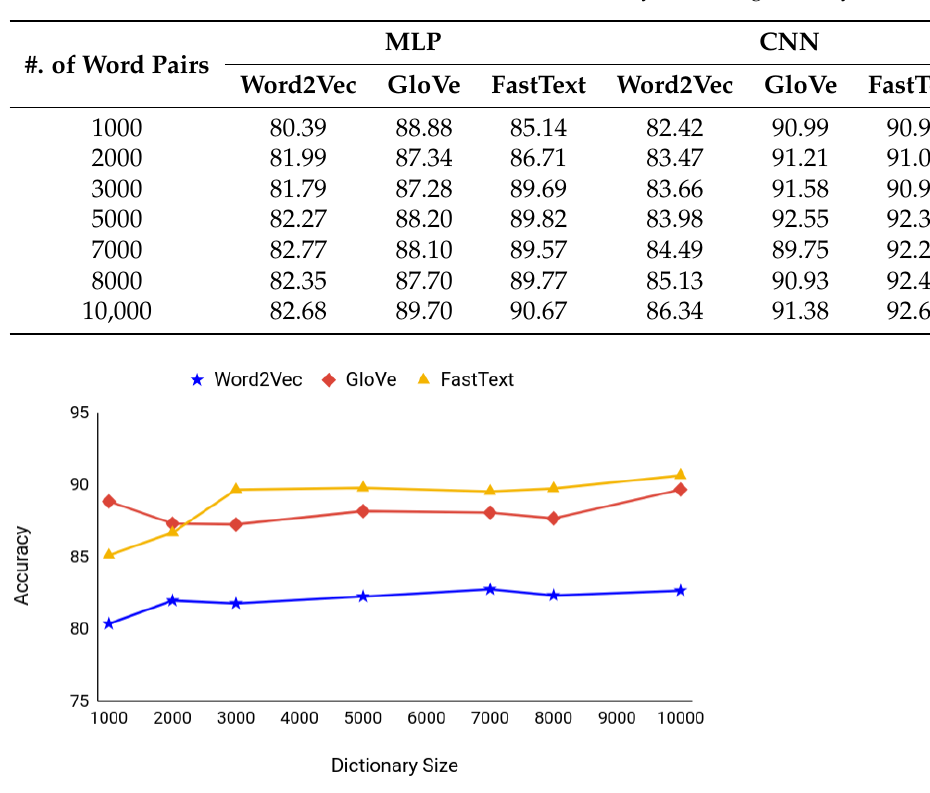
Table 5. Pairwise Accuracy of MLP and CNN Network over various dictionary lengths. P.accuracy was chosen because it is more difficult to achieve than N.accuracy and is linguistically verifiable.